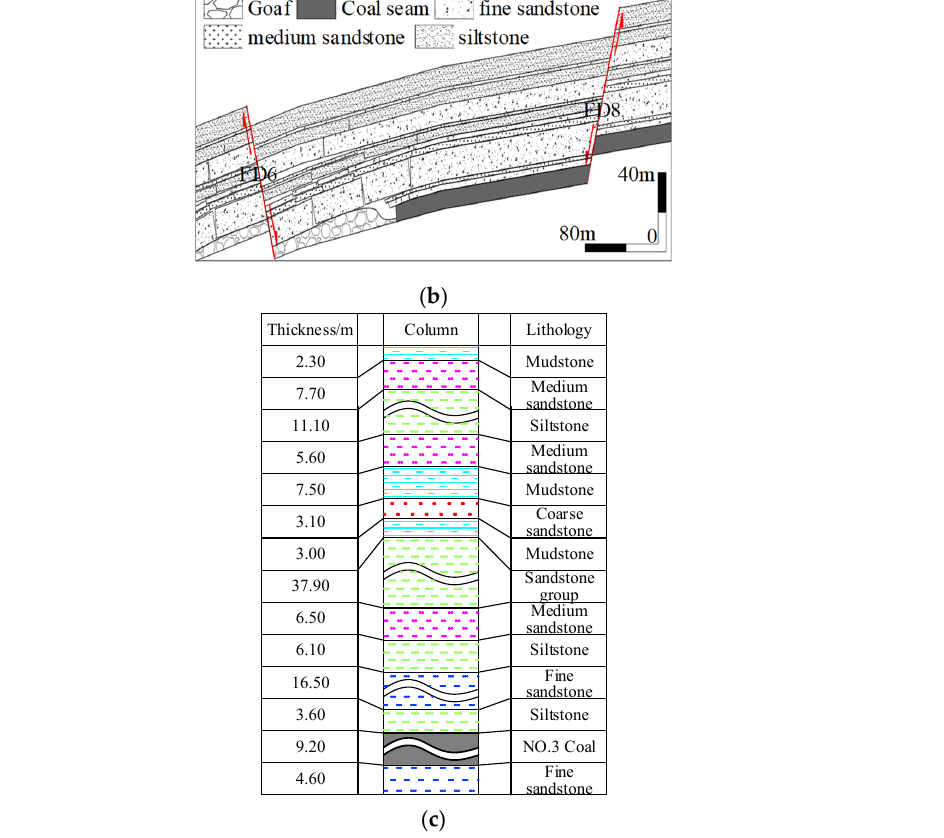
Figure 2. ( a ) Seismic events distribution (from the time the longwall started to retreat until rock burst occurred) of LW2305S. Purple crosses represent events with energy from 0 to 10 3 J, blue filled circles represent events with energy from 10 3 to 10 4 J, pink unfilled rhombuses represent events with energy from 10 4 to 10 5 J, pink filled rhombuses represent events with energy from 10 5 to 10 6 J, and red filled circles represent events with energy over 10 6 J. ( b ) A-A cross-section of LW2305S in Figure 2a. The red arrows represent the moving direction of the fault block. ( c ) Stratigraphic column of LW2305S. (It is noticed that the stratigraphic column of a longwall face is usually plotted by comprehensively considering the strata distribution around the longwall face rather than for specific sites. The same applies to similar descriptions elsewhere in this work).